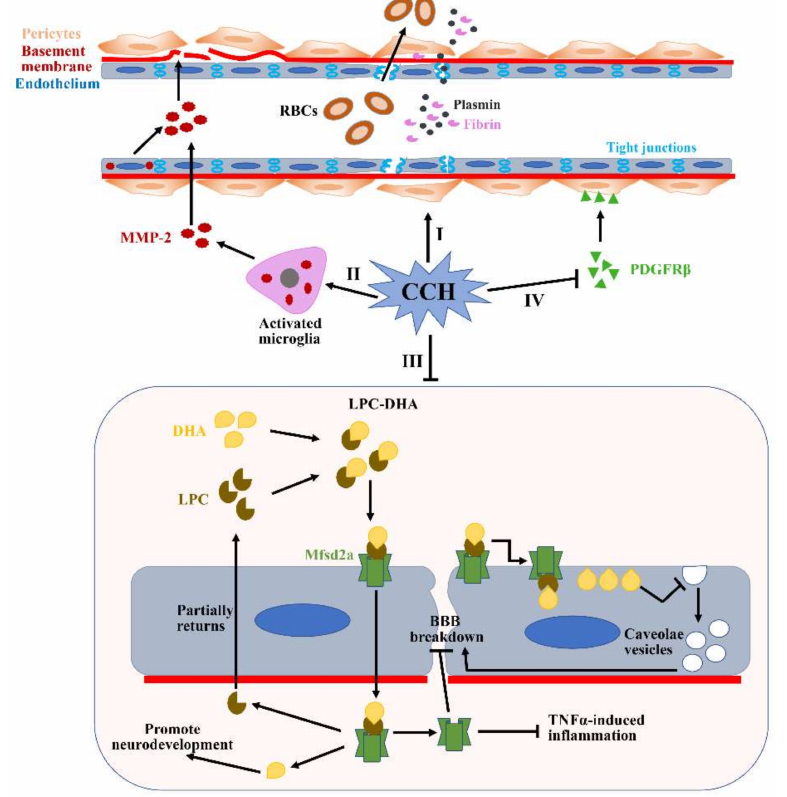
Figure 4. Potential mechanisms of BBB breakdown during CCH. ( I ) Pericytes detach from the perivascular positions under the CCH condition, which subsequently reduce the expression of tight junction proteins. Additionally, CCH can also directly disrupt the expressions of tight junction proteins. ( II ) CCH can upregulate levels of MMP2 expression in the activated microglia and en- dothelium. Increased MMP2 can accelerate the degradation of many major ECM constituents, such as collagen IV, fibronectin and gelatin. ( III ) Mfsd2a plays a critical role in transporting DHA